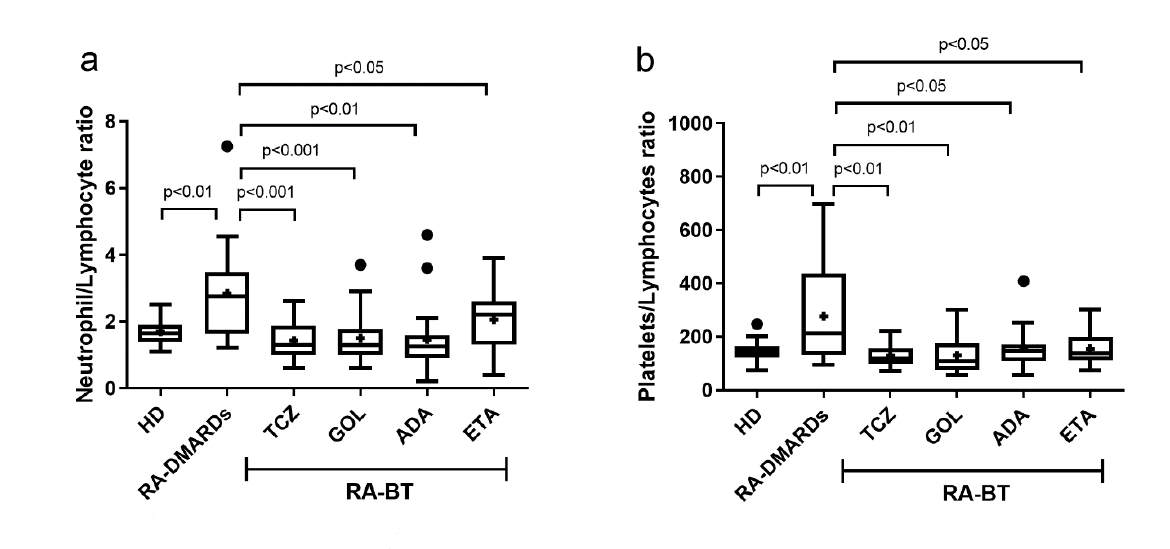
Figure 4: The neutrophils to lymphocytes ratio and platelets to lymphocytes ratio in healthy do- nors (control), and RA patients undergoing a standard RA therapy (RA-DMARDs) or different types of biological treatment (RA-BT). Differences in values of neutrophils to lymphocytes ratio ( a ) and platelets to lymphocytes ratio ( b ) were compared for healthy donors (HD, n = 20), patients with RA without BT (RA-DMARDs; n = 20), and RA patients receiving distinct BT (RA-BT) - tocilizumab (TCZ, n = 20); golimumab (GOL, n = 20); adalimumab (ADA, n = 20); or etanercept (ETA, n = 19). Data are presented as box plots displaying the median, mean (+), 25 th and 75 th percentiles, minimum and maxi- mum (whiskers), and outliers’ values (●). The statistical difference was determined by unpaired two- tailed Student's t-test. The difference with p<0.05 was considered